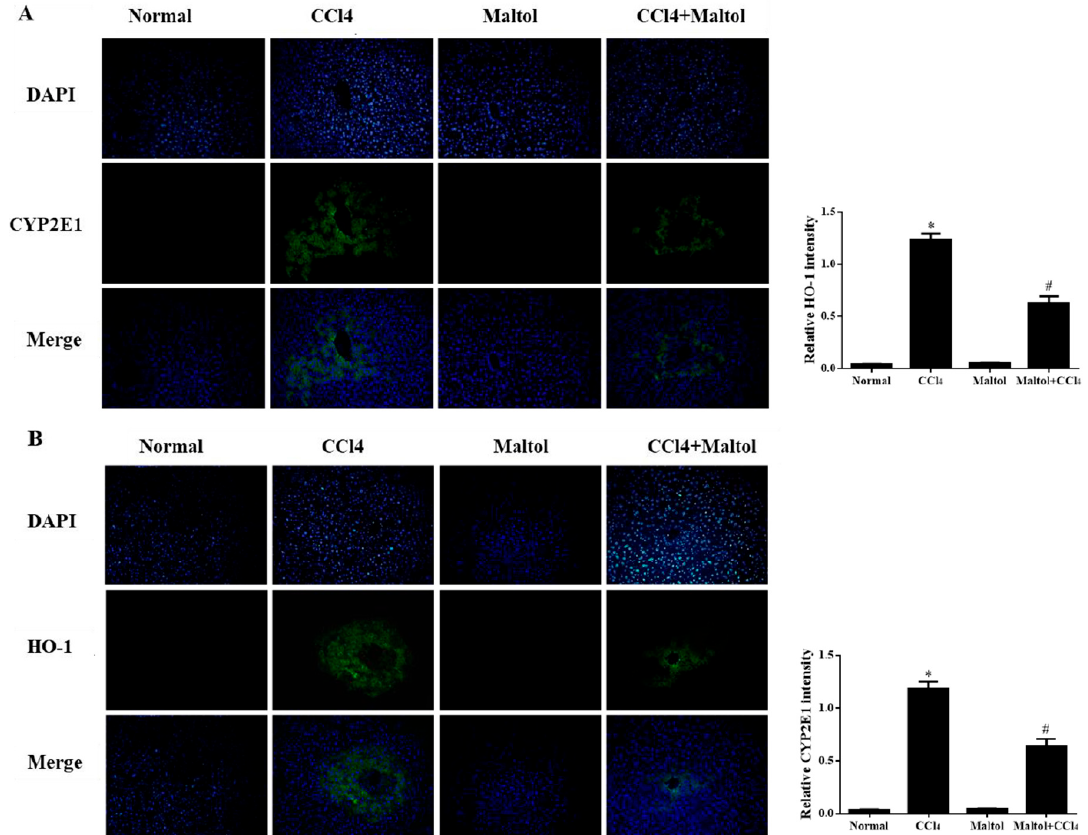
Figure 5. Pretreatment with maltol protected against CCl 4 -induced liver injury: Liver cells stained with immunofluorescence probes of cytochrome P450 E1 (CYP2E1) ( A ) and heme oxygenase-1 (HO-1) ( B ). Representative quantification of immunofluorescence images at 200 × . 4,6-Diamidino-2-phenylindole (DAPI) was used as a nuclear counterstain. Values are expressed as the mean ± S.D., n = 8. * p < 0.05 vs. normal group; # p < 0.05 vs. CCl 4